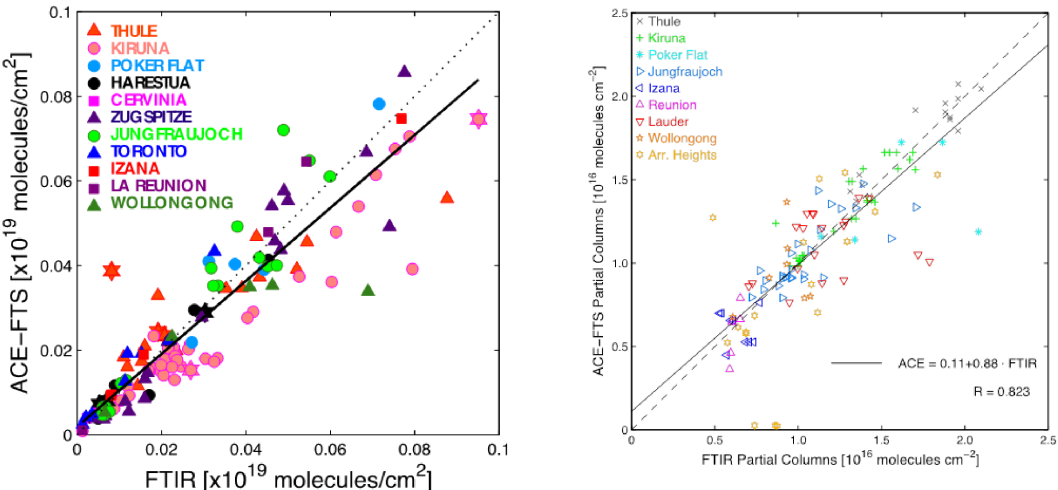
Figure 7. Examples of the validation of new satellite data sets. Panel (a) is reprinted from (Clerbaux et al., 2008) for lower-stratospheric CO measured at 5µm from 11 instruments, 9 of which are located at NDACC stations. The partial column quantities from the ACE-FTS and the FTIR have very similar characteristics in vertical resolution and analysis, providing a precise evaluation of satellite performance. The latitudinal extent of the NDACC sites here from 76 ◦ N to 34 ◦ S helps verify the ACE-FTS global coverage. Panel (b) reprinted from (Wolff et al., 2008) shows the correlation of partial columns for HNO3 measured at 10.02µm from nine NDACC stations from 76 ◦ N to 78 ◦